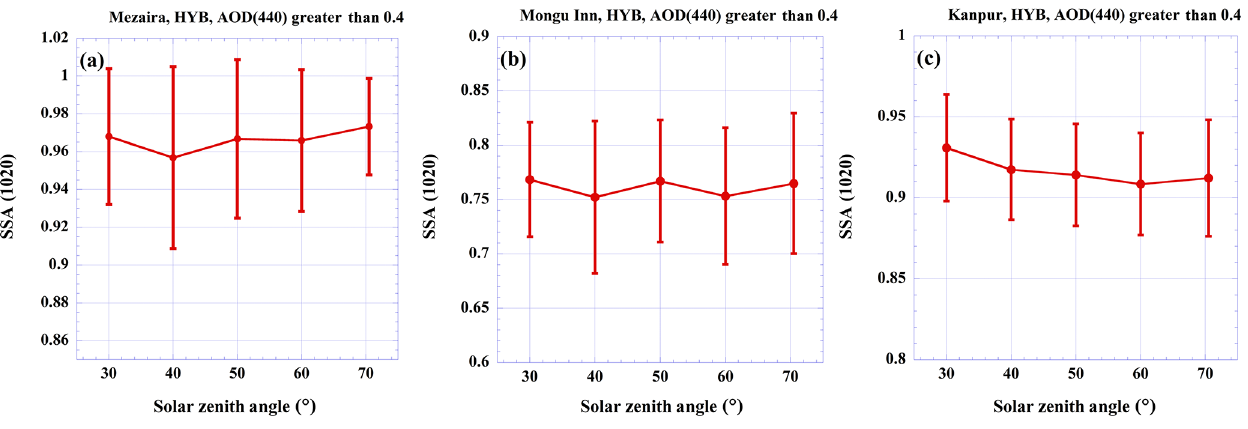
Figure 16. Dependence of 1020nm SSA hybrid scan retrievals on SZA for three AERONET sites: (a) Mezaira, (b) Mongu Inn, (c)